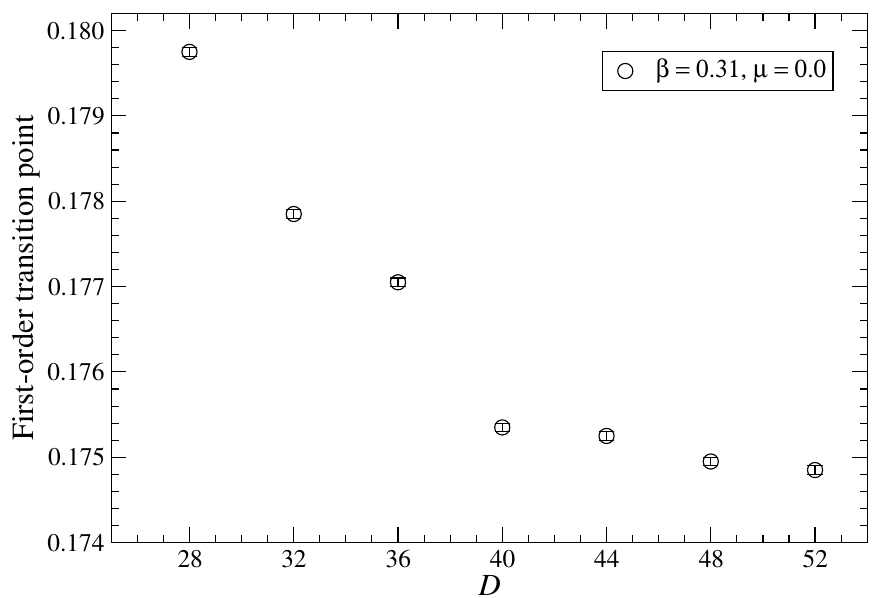
Figure 7 . Convergence behavior of the transition point of η as a function of D at β = 0 . 31 with vanishing µ . Error bars are all within the